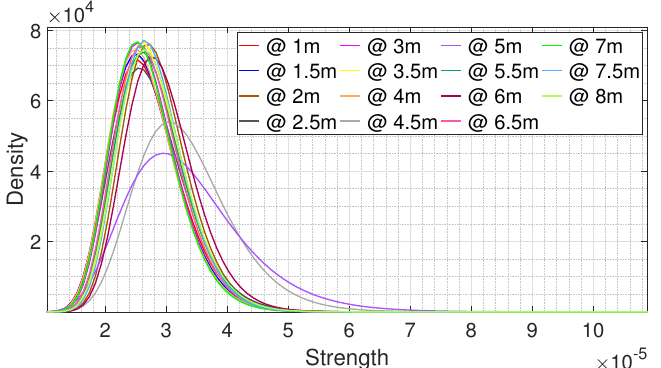
Figure 8. The fitting results for the noise signals at different distances.